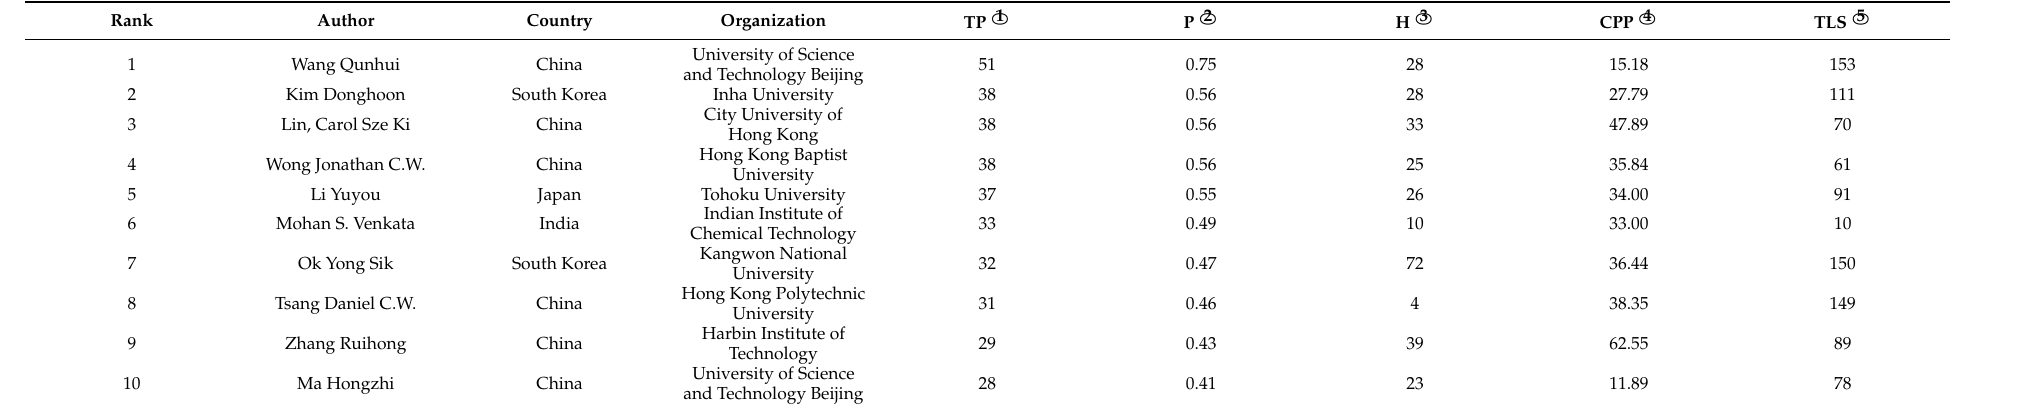
Table A2. Top 10 authors with the most publications in FW